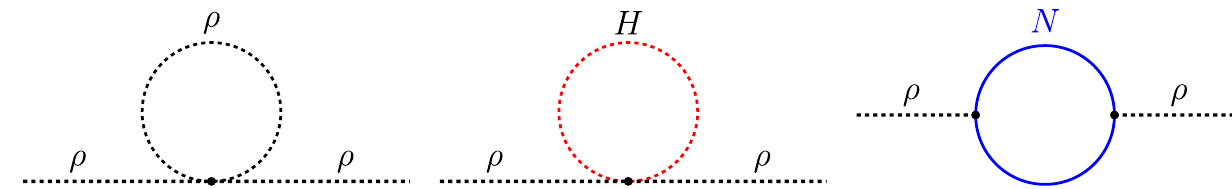
Fig. 8 Three relevant contributions to the thermal mass of the CP-even scalar ρ . See Eq. (A5) for the actual contribution